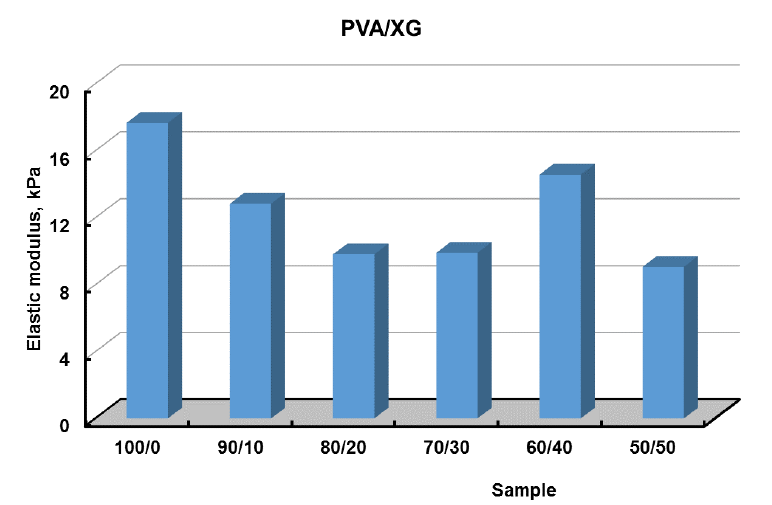
Figure 9. The values of elastic modulus for PVA/XG hydrogels prepared with different ratios be- tween PVA and XG.